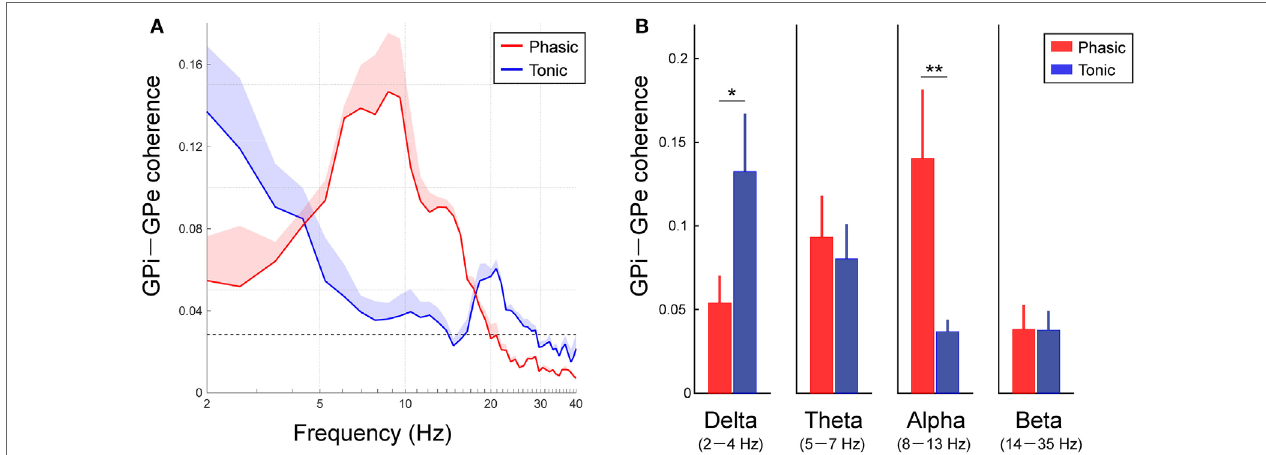
FigUre 3 | Resting-state GPi–GPe functional couplings in phasic and tonic dystonia patients. (a) Red and blue lines represent the averaged GPi–GPe coherence profiles in the phasic and tonic patients, respectively. The x -axis shows the log scale. The shaded area represents the SE. The black horizontal dotted line shows the significant level of coherence. Significant coherence is found at the peak around the alpha band in the phasic and tonic patients. (B) The mean value of GPi–GPe coherence over the delta (2–4 Hz) (a), theta (5–7 Hz) (b), alpha (8–13 Hz) (c), and beta (14–35 Hz) (d) bands in the phasic (red) and tonic (blue) patients. Error bars represent the SEs. Significant differences in coherence between phasic and tonic symptoms of dystonia are found in the delta and alpha bands (* p < 0.05 and ** p <